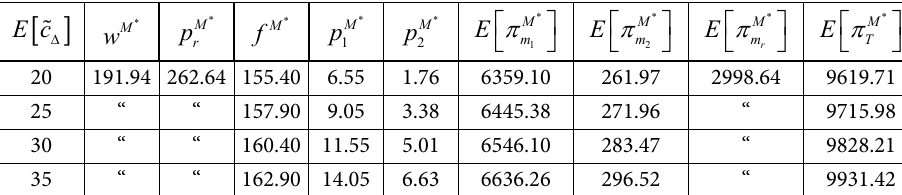
Table 6. Decentralized decision-making with the change of expected value of c ∆